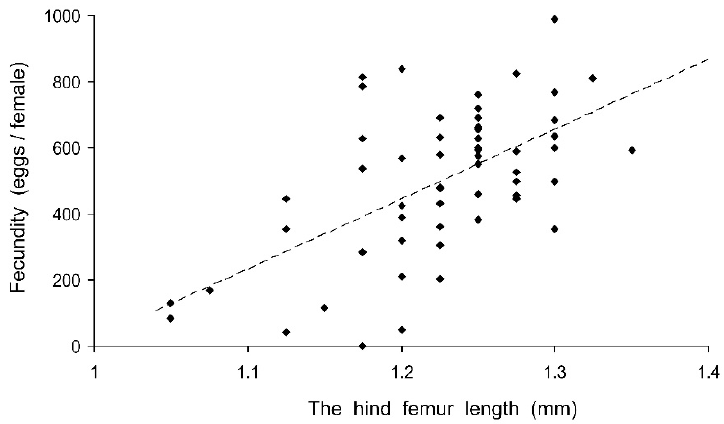
Figure 3. Fecundity of Cheilomenes propinqua females in relation to their size, as estimated by the hind femur length. Each symbol corresponds to one control female. The dashed line shows the linear regression Y = 2079 X − 2046 (r = 0.584, n = 58, p < 0.001). Table 2. Influence of the trophic regime, temperature, humidity, and duration of storage on the fecundity of Cheilomenes propinqua females (the results of the GLM analysis: the regression coeffi- cient ± SE, t -ratio, and significance of influence).